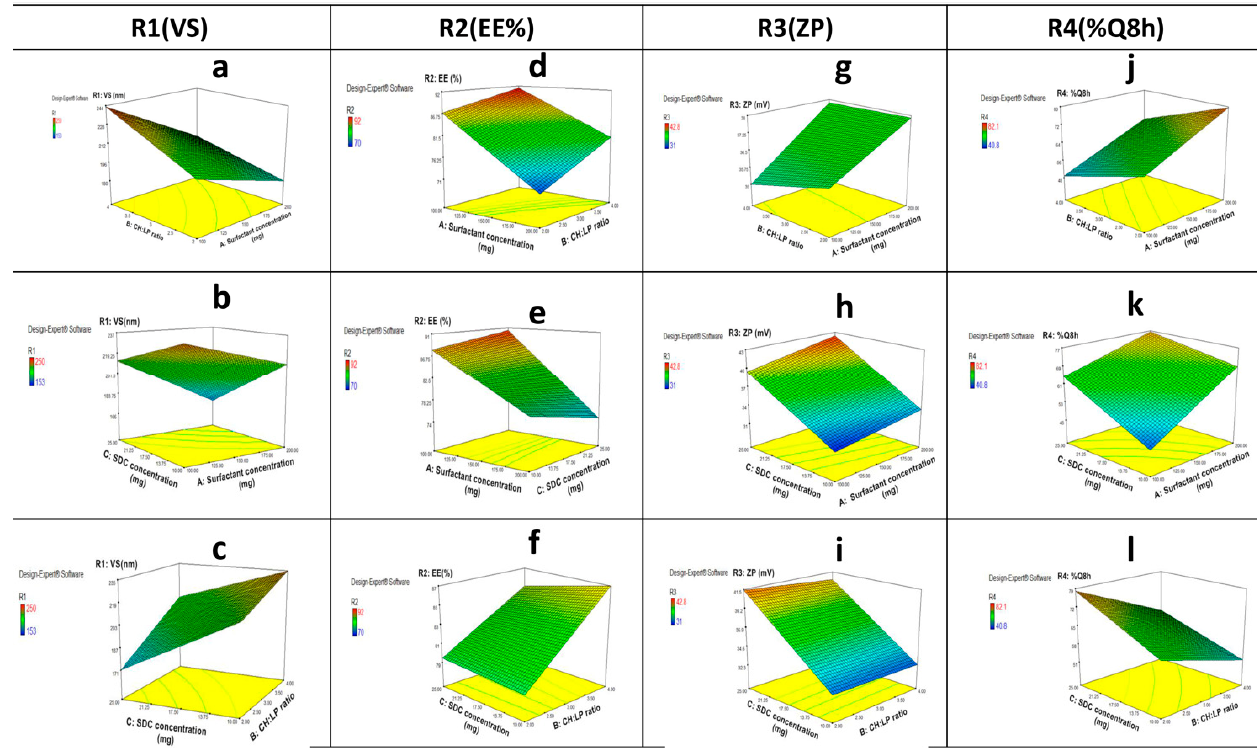
Figure 4. 3D surface plots of the effect of variables; (A) surfactant concentration, (B) CH:LP molar ratio, and (C) SDC concentration on different responses following: ( a ) the effect of A and B on R1, ( b ) the effect of A and C on R1, ( c ) the effect of B and C on R1, ( d ) the effect of A and B on R2, ( e ) the effect of A and C on R2, ( f ) the effect of B and C on R2, ( g ) the effect of A and B on R3, ( h ) the effect of A and C on R3, ( i ) the effect of B and C on R3, ( j ) the effect of A and B on R4, ( k ) the effect of A and C on R4, and ( l ) the effect of B and C on R4.